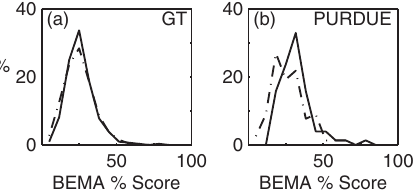
FIG. 5. Average BEMA scores by section at Georgia Tech—the average end-of-semester BEMA scores for 11 traditional (cid:1) T# (cid:2) and 5 M&I (cid:1) M# (cid:2) sections at GT are shown. The error bounds indicate 95% confidence intervals on the estimates of the average for each section. The number of students tested in a particular section is given by N m in Table I.